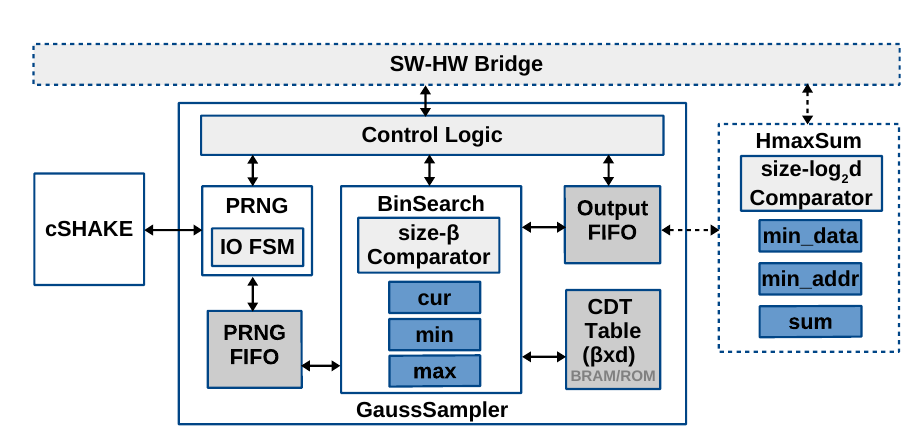
Figure 2: Dataflow diagram of the GaussSampler and HmaxSum hardware modules. The HmaxSum module can be conditionally added in the design to accelerate the qTESLA com-